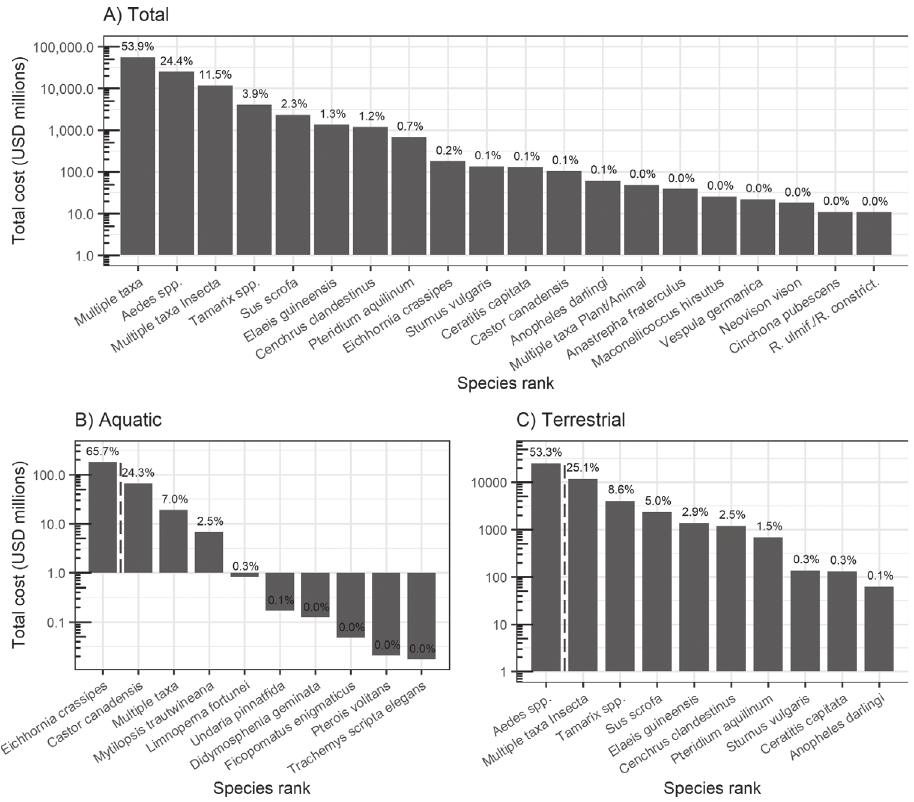
Figure 4. Costs of biological invasions per taxa in Central and South America A twenty costliest taxa B the ten costliest taxa on aquatic environments, and C the ten costliest taxa on the terrestrial environ- ments. The hyper-costly taxa appear on the left side of the dashed line. Aedes spp. represents Aedes aegypti and Aedes albopictus ; R. ulmif./R. constrict. represents Rubus ulmifolius and Rubus constrictus